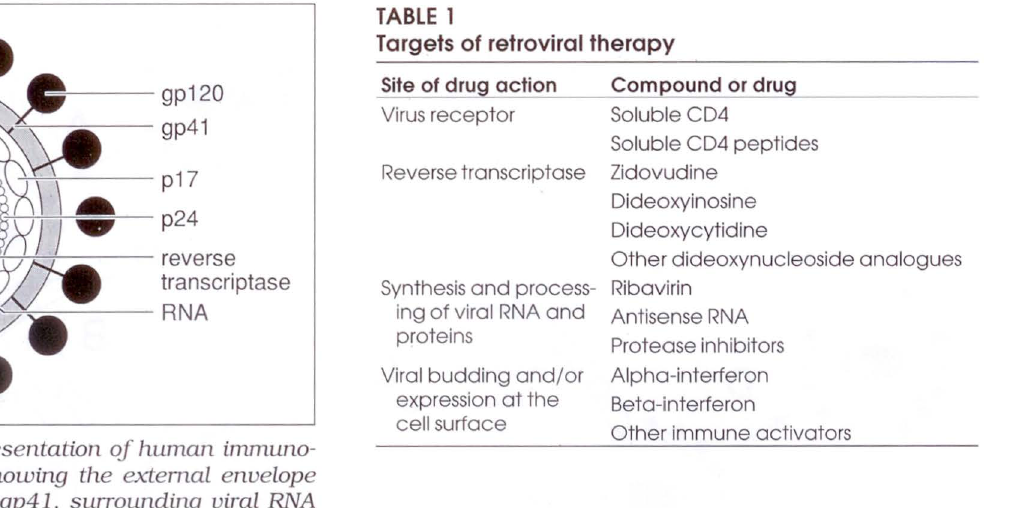
Figure 2) Schematic representation of human